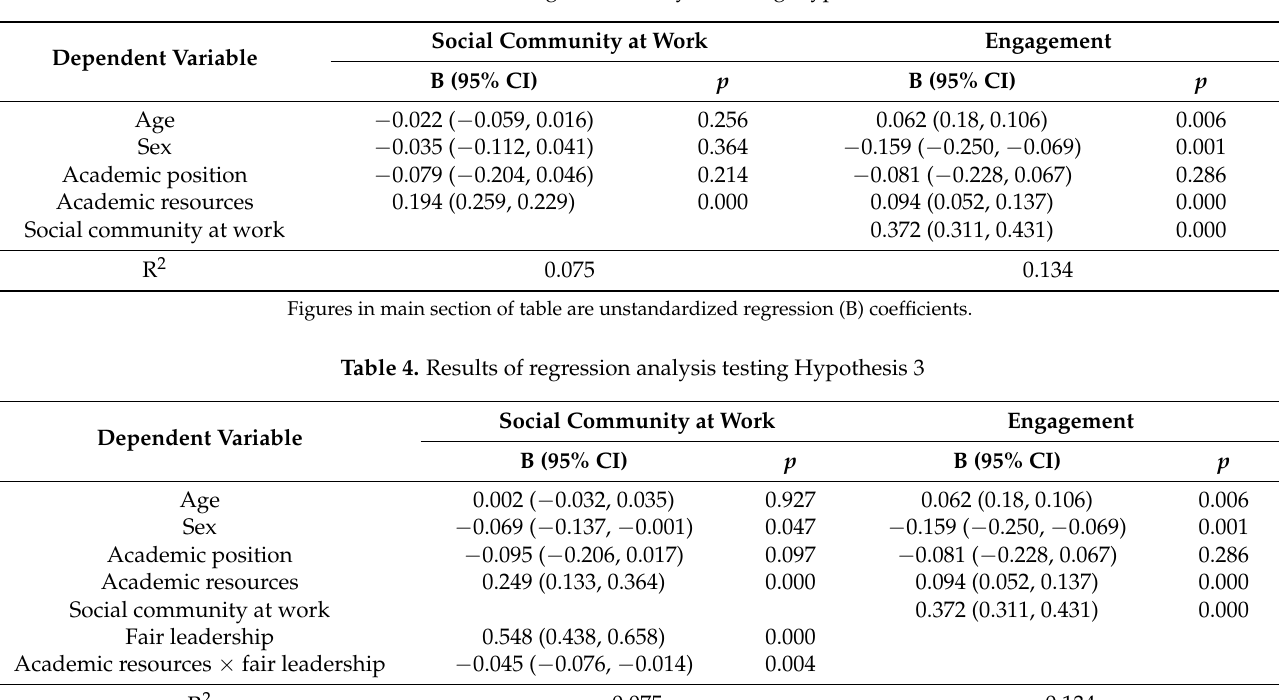
Table 3. Results of regression analysis testing Hypothesis 2.